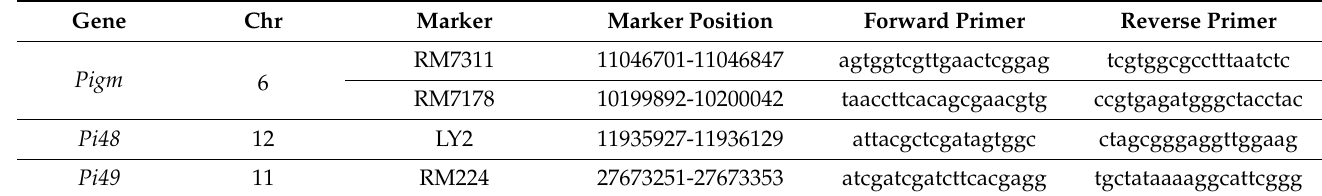
Table 1. Molecular markers used to select individuals with the resistance